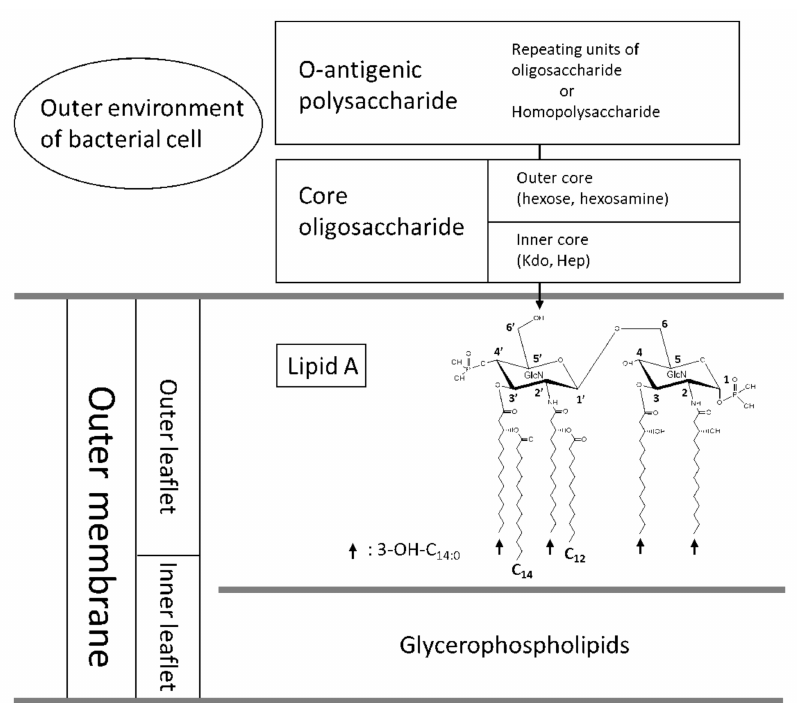
Figure 1. Schematic elucidation of outer membrane and chemical structure of lipid A region with the numbering of carbon atoms in the glucosamine–disaccharide